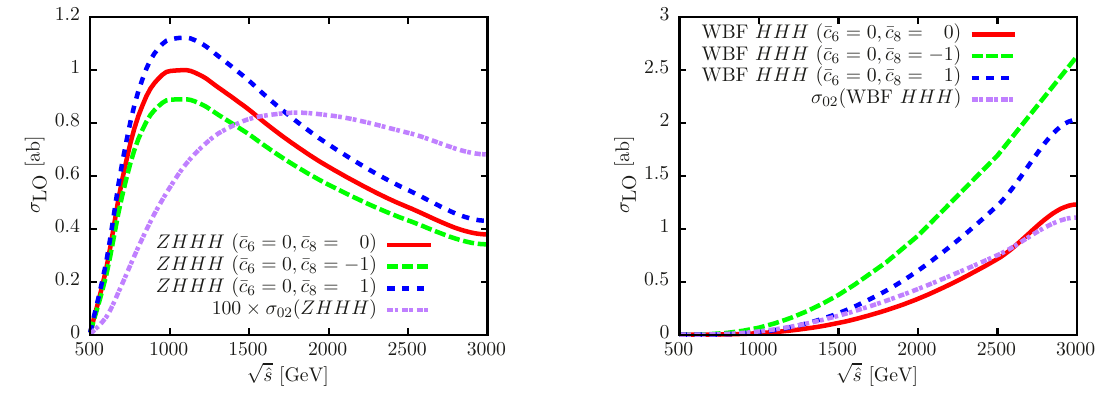
p ^ s for representative values